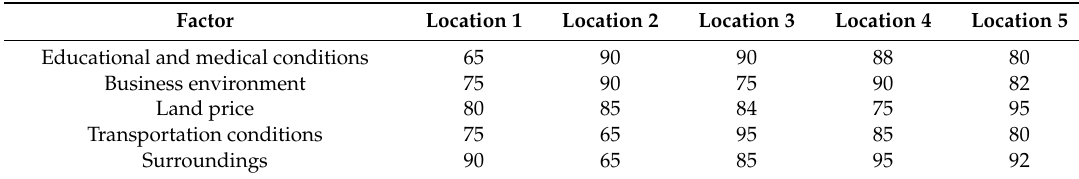
Table 6. Scores of the factors for the proposed locations [18].